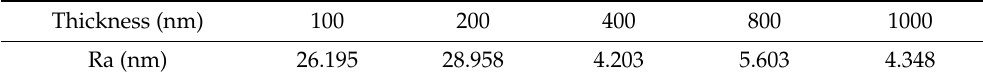
Figure 5. AFM images of thin film samples with different film thicknesses: ( a ) 100 nm; ( b ) 200 nm; ( c ) 400 nm; ( d ) 800 nm; ( e ) 1000 nm. Table 4. Surface roughness of thin film samples with different thicknesses.